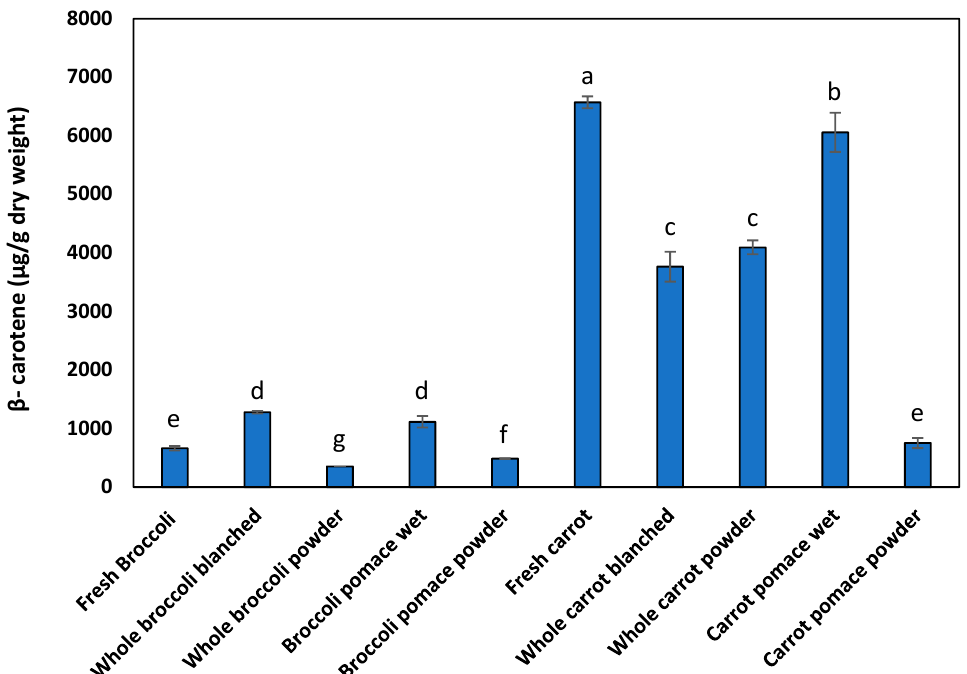
Figure 3. Carotenoid content of raw and processed vegetables (Trial 1—powders freeze dried). Different lowercase letters indicate that there is a significant difference, p < 0.05.